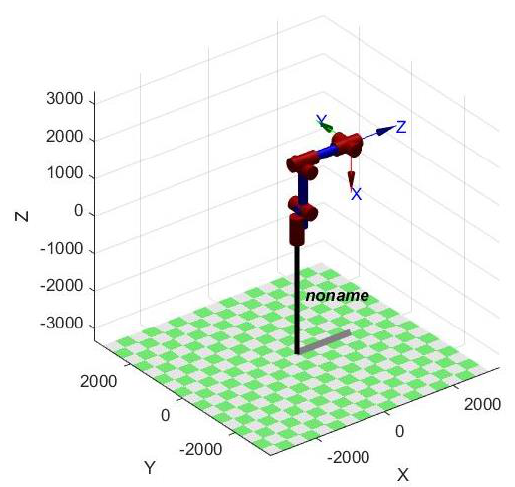
Figure 3. Six-degree-of-freedom (6-DOF) serial manipulator.